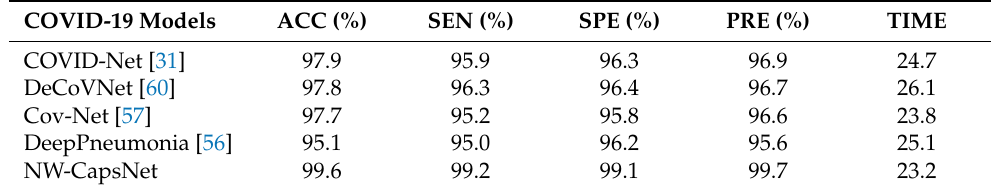
Table 5. Comparison of our proposed NW-CapsNet model with other selected state-of-the-art COVID-19 models using the same training data